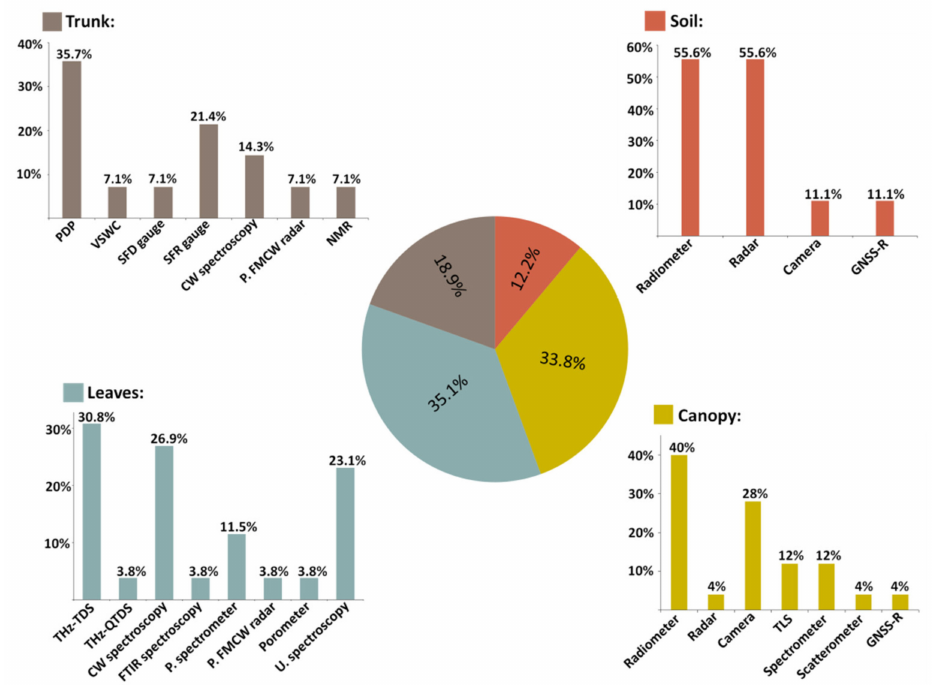
Figure 10. Circle chart including the percentage of publications applied to soil, canopy, leaves and trunk or stems, together with the percentage of the used technologies within each section. CW = Continuous-wave, FMCW = Frequency-modulated continuous-wave, FTIR = Fourier transform infrared, GNSS-R = Global navigation satellite system-reflectometry, NMR = Nuclear magnetic reso- nance, P = Portable, PDP = Portable dielectric probe, QTDS = Quasi time domain spectroscopy, SFD = Sap-flux density, SFR = Sap-flow rate, TDS = Time domain spectroscopy, TLS = Terrestrial laser scanning, U. = Ultrasonic, VSWC = Volumetric soil water